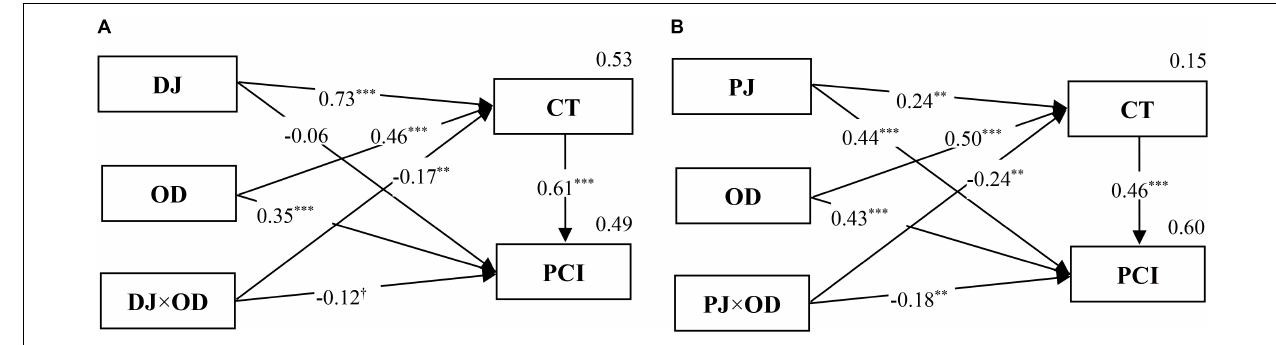
FIGURE 5 | The mediated moderation model of DJ (A) , PJ (B) , OD, and CT on PCI (Study 1). n = 320; ∗∗∗ p < 0.001, ∗∗ p < 0.01, † p < 0.10.